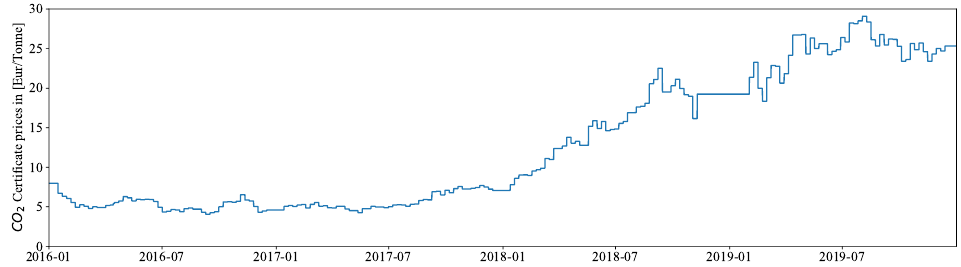
Figure 3. Historical development of CO 2 prices in the simulation